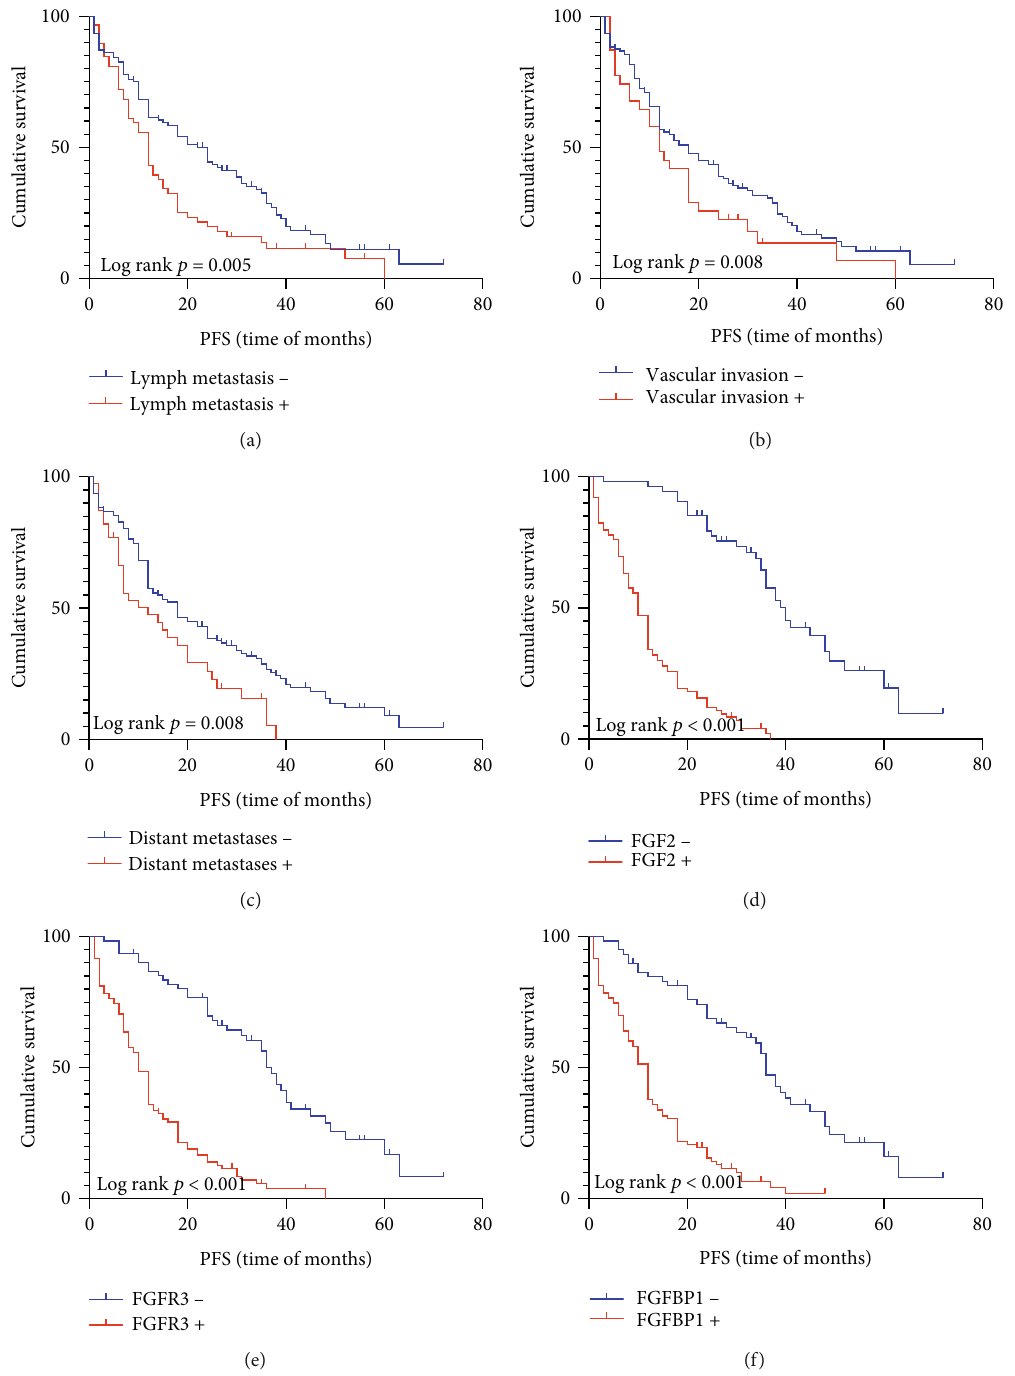
Figure 5: Kaplan – Meier curves for PFS of ESCC. (a) Patients with lymph node metastasis have a signi fi cantly shorter survival ( p = 0 : 005 ); (b) patients with vascular invasion have a signi fi cantly shorter survival ( p = 0 : 008 ); (c) the prognosis of patients with distant metastasis is poor ( p = 0 : 008 ); (d) patients expressing high level of FGF2 have a signi fi cantly shorter survival ( p < 0 : 001 ); (e) patients expressing high level of FGFR3 have a signi fi cantly shorter survival ( p < 0 : 001 ); (f) patients expressing high level of FGFBP1 have a signi fi cantly shorter survival ( p < 0 : 001